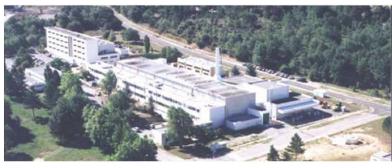
Fig. 2. The CHICADE facility.